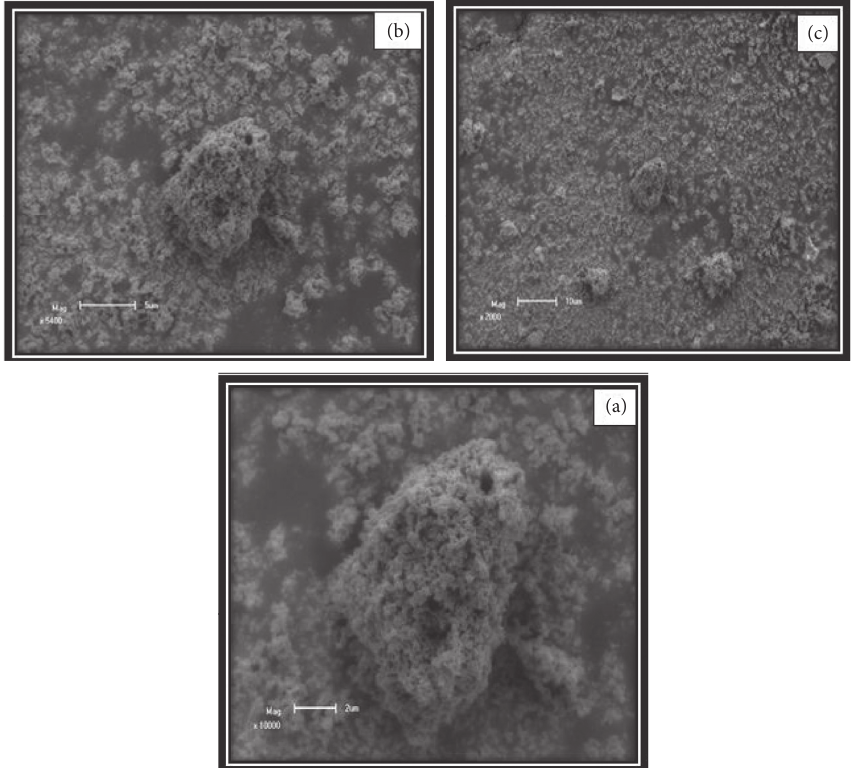
Figure 2: The scanning electron microscope micrograph of nano-synthesized lead selenide films grown varying temperatures: (a) 20. (b) 45. (c) 85 °